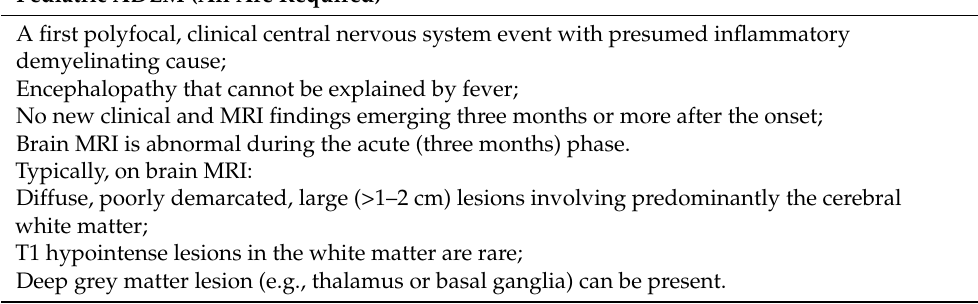
Table 3. International Pediatric Multiple Sclerosis Society Group (IPMSSG) diagnostic criteria